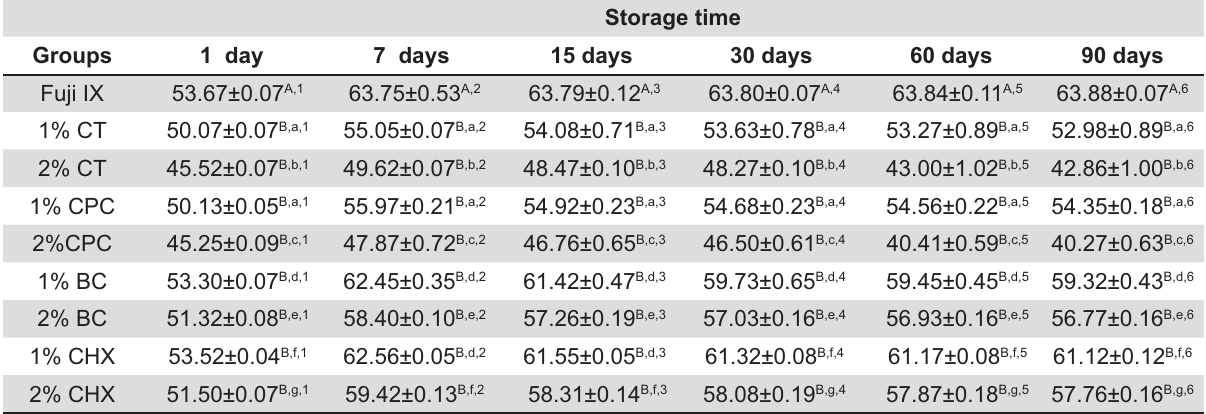
Table 1- Mean Vickers hardness number (VHN) values of all groups±standard deviations (sd) during the study period after storage in distilled